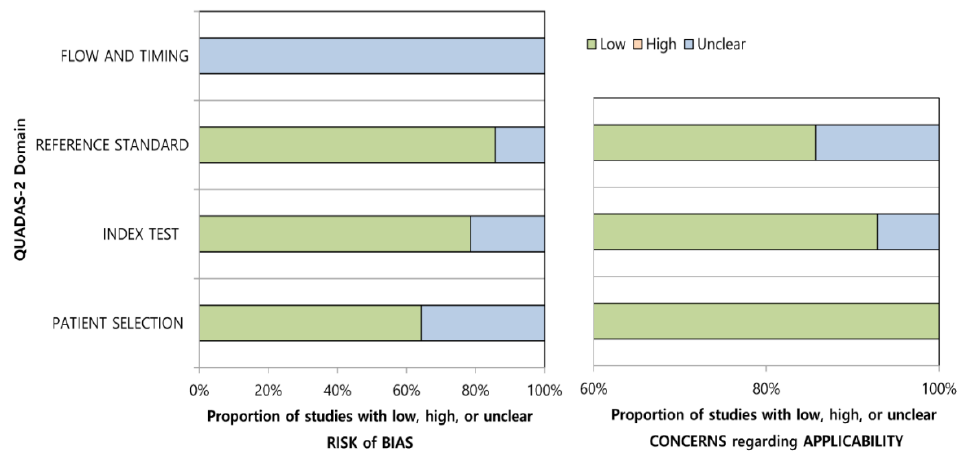
Figure 2. Quality Assessment of Diagnostic Accuracy Studies-2 (QUADAS-2) criteria for the assessment of the 14 included studies.